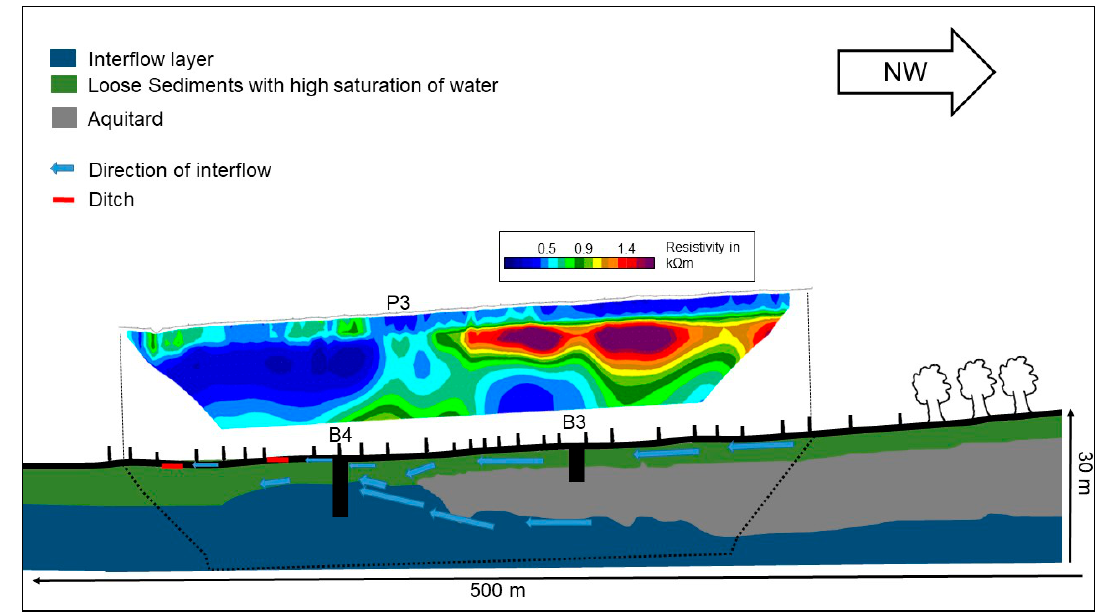
Figure 13. Model2: drained part of "Thranenbruch".